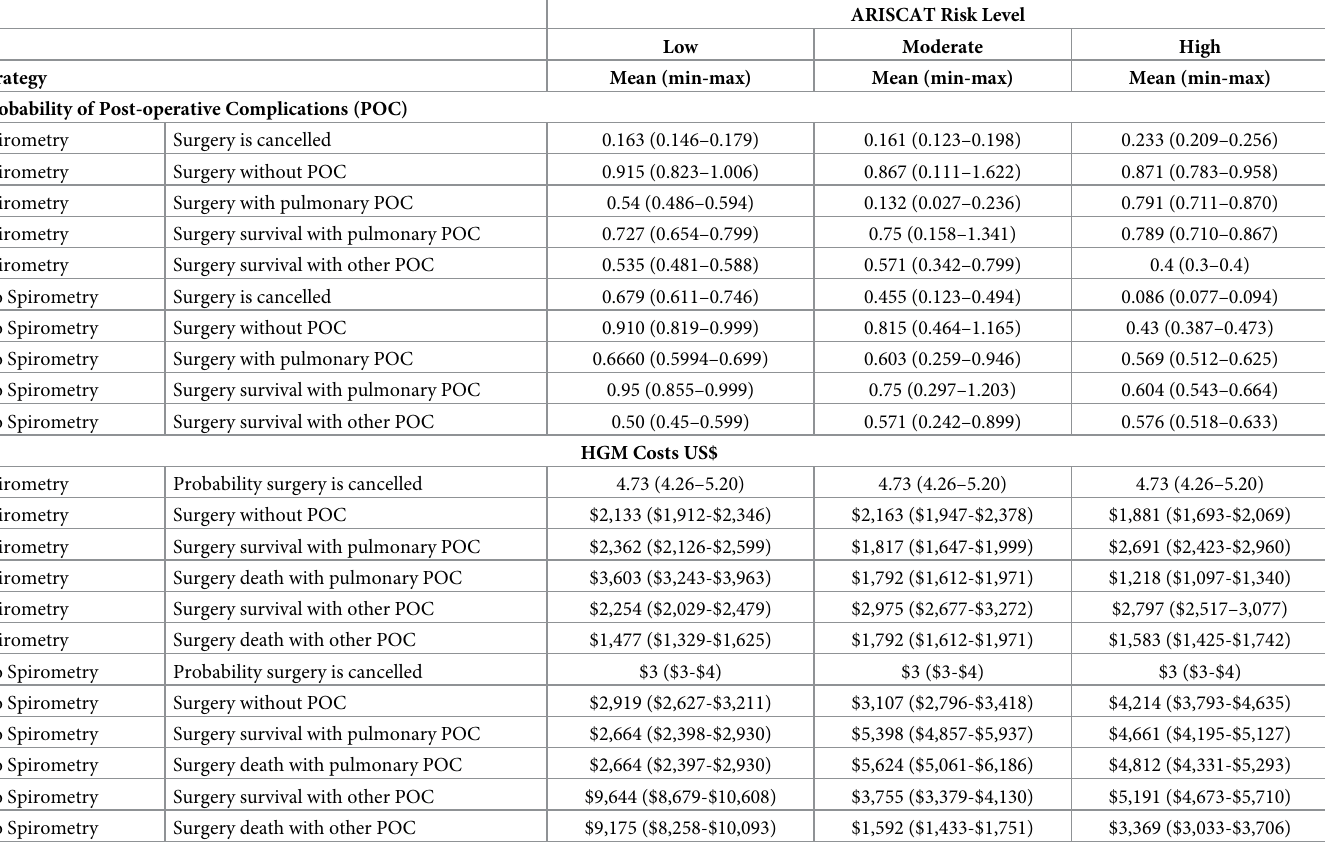
Table 1. Parameter values of base case model, by ARISCAT risk level, with and without spirometry. Probabilities and average costs ($US).